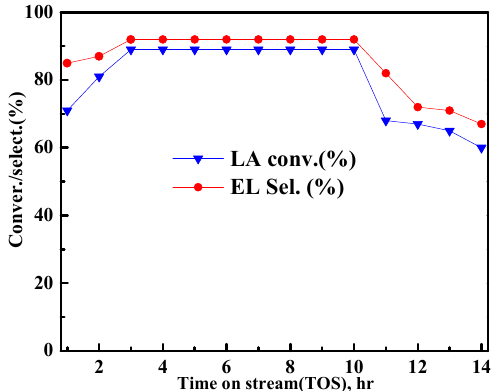
Figure 8. Time on stream studies of Pt/STA-ZrO 2 catalyst on LA esterification.